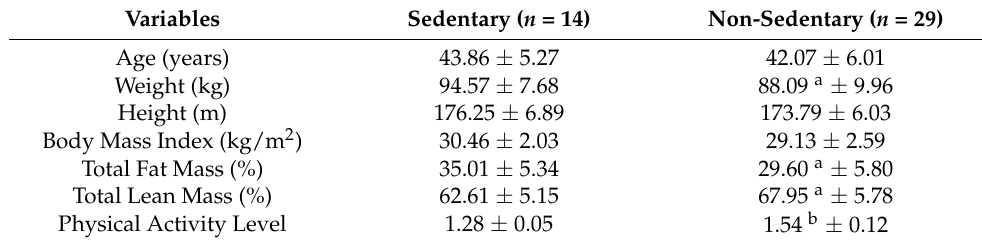
Table 1. Characteristics of the study sample ( n =